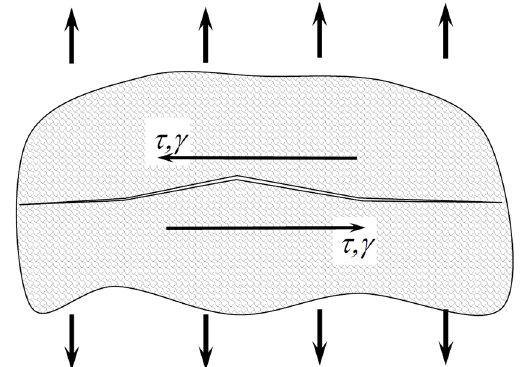
Figure 2. Interpretation of the SWT parameter defined by the shear component.